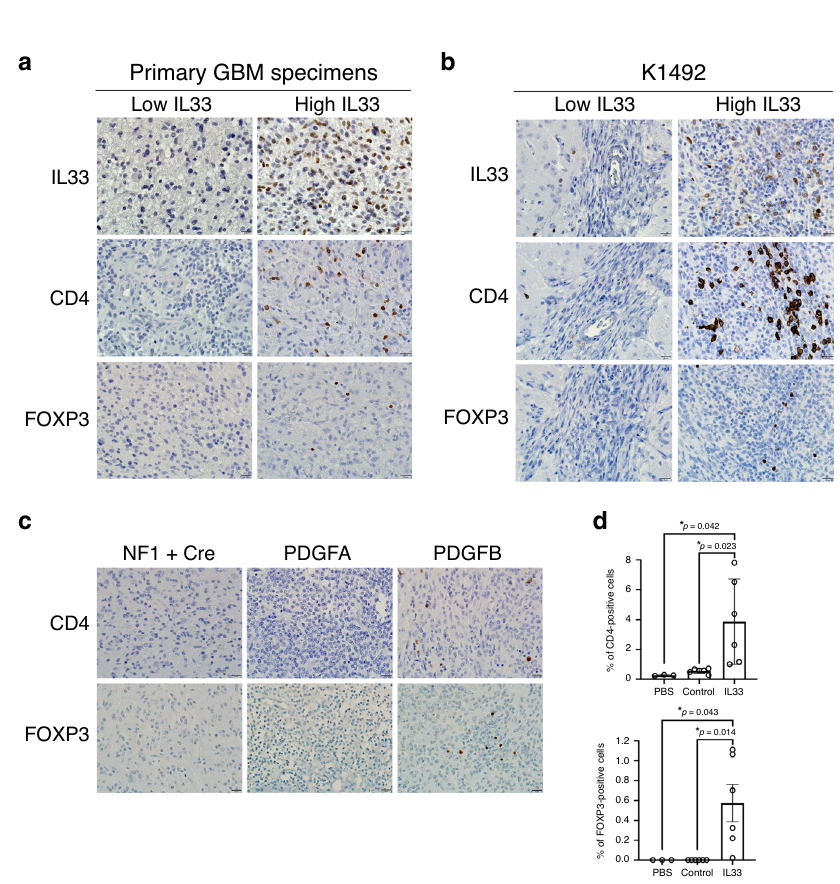
Fig. 6 FOXP3 + T cells in IL-33-expressing tumors. Shown are representative IHC (brown) for IL-33, CD4, and FOXP3 in a primary GBM specimens (CD4 N = 5; FOXP3 N = 5), b syngeneic K1492-control and IL-33 + mouse glioma (CD4 N = 6; FOXP3 N = 6), and c PDGFB, PDGFA, and shNF-1/Cre-driven glioma (CD4 N = 3, FOXP3 N = 3). Sections were counterstained with hematoxylin (blue). Scale bars: 20 µ m. d Graph shows the quantitation of CD4 + (upper panel) and FOXP3 + (lower panel) cells present in K1492-control ( N = 6) or IL-33 + ( N = 6) xenografts. Mice injected with PBS were used as sham controls ( N = 3). Results are expressed as the mean ± SEM of the percentage of positive cells/whole brain section (K1492-control and IL-33 + 6 mice/ group; sham control 3 mice/group); * p ≤ 0.05 by one-way ANOVA with Tukey ’ s post hoc test. Source data are available as a Source data fi